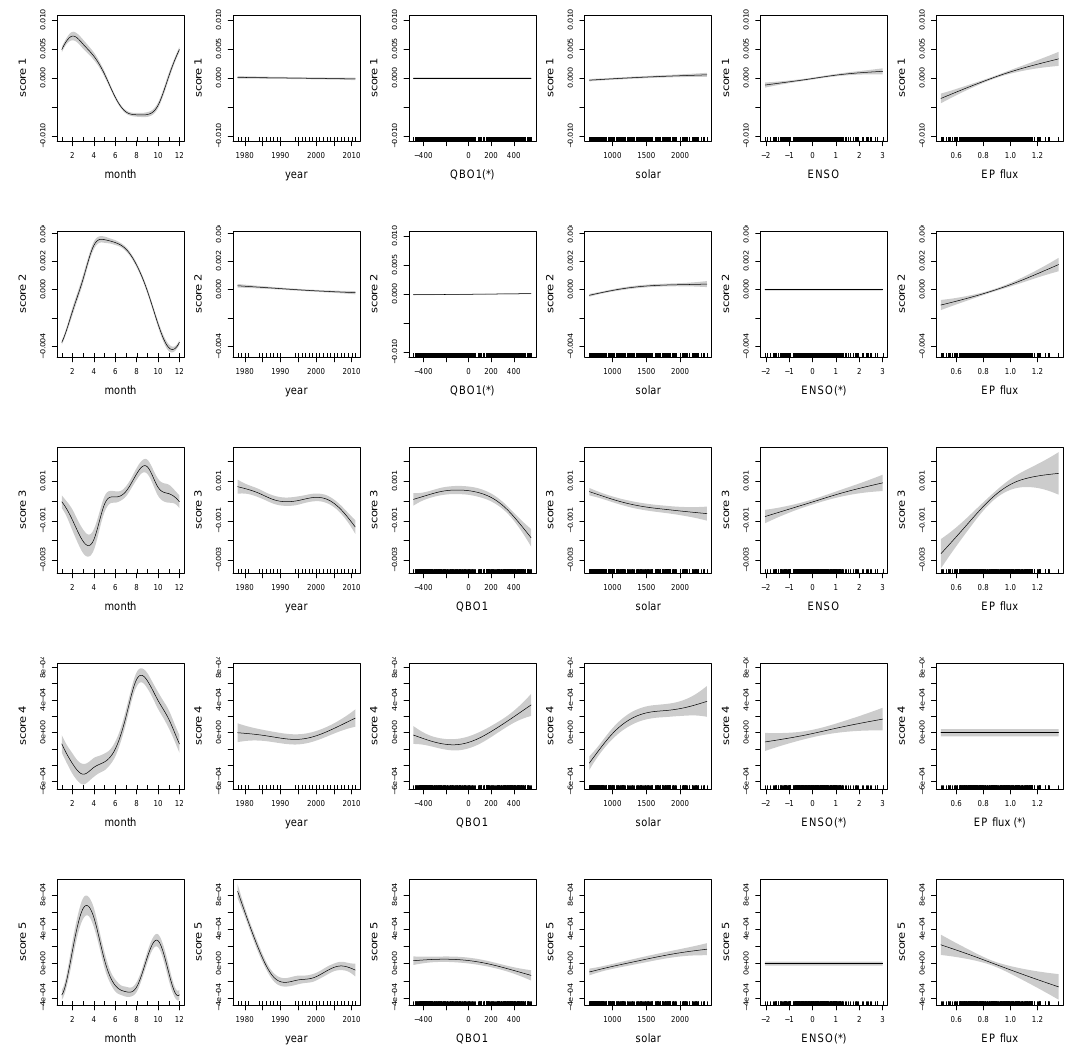
Fig. 6. Fitted smooth curves (black solid lines) and their 95% Bayesian confidence intervals (shaded areas) from AMMs of Boulder for selected covariates (AO and QBO2 are excluded for all scores as none of these covariates are significant; see Table 1). The associated PC score and the covariate are marked as x and y labels. When the associated covariate is insignificant, under the 5% significance level, ( ∗ ) is added to the x label. The unticked years in the fitted curves of year represent volcanic periods omitted from our analysis.